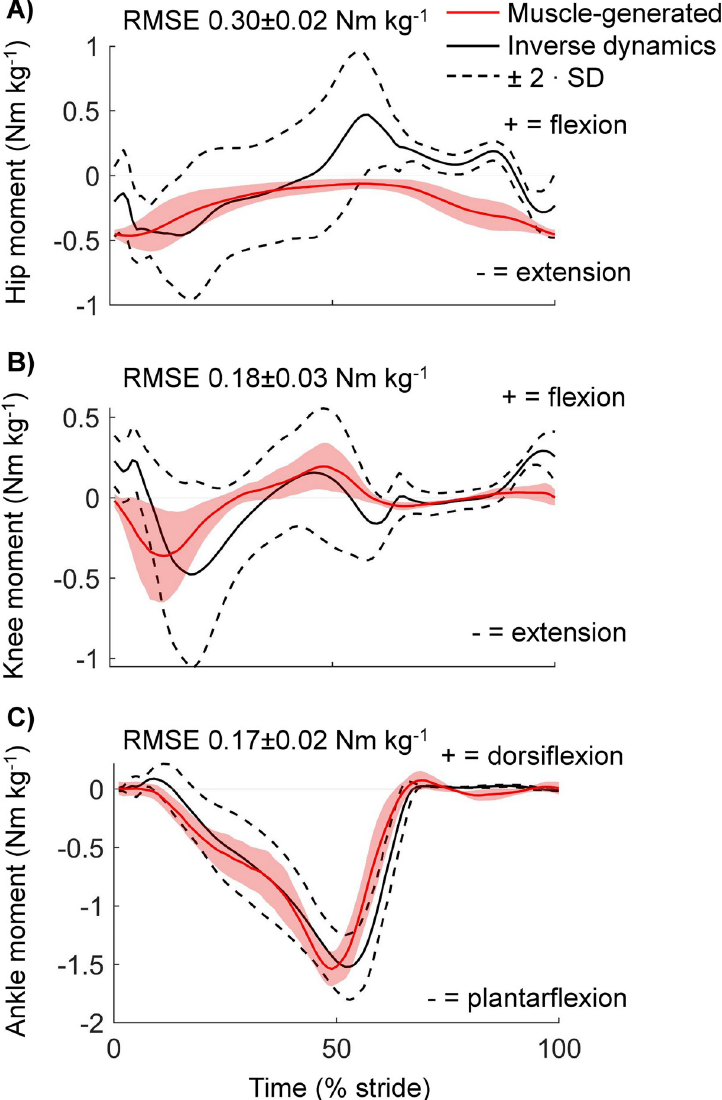
Fig 5. Musculoskeletal method validation. (a) Hip moments, (b) Knee moments, (c) Ankle moments. Red lines represent the net joint moments from the simulated muscles in the normal walking condition. The shaded area is s.e. m. The black line represents the net joint moments from inverse dynamic analyses. Dashed lines represent the mean inverse dynamics joint moments ± two times the standard deviation, which is suggested as a validation threshold [38]. Values in the plots represent mean ± inter-subject s.e.m. of root mean square errors of the difference between muscle- generated and inverse dynamics moments. The muscle-generated hip moments followed the inverse dynamics moments in the extension direction but not in the flexion direction since the optimization algorithm was programmed only to minimize the error during hip extension moment generation.